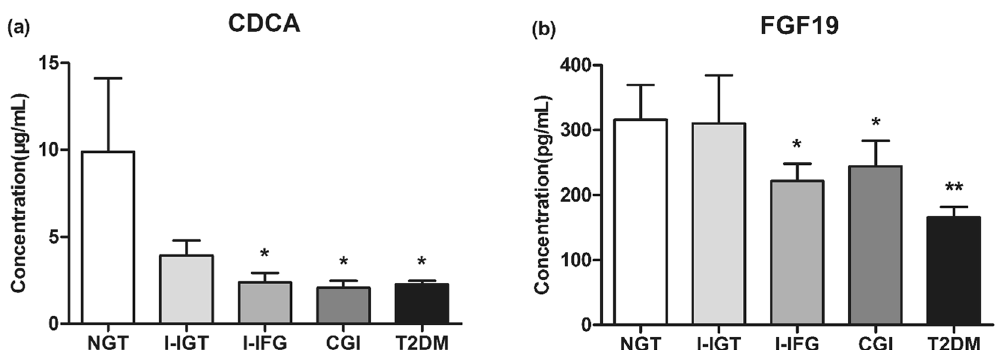
Figure 3. Fasting serum CDCA ( a ) and FGF19 ( b ) concentration in subjects with NGT (n = 10), I-IGT (n = 9), I-IFG (n = 10), CGI (n = 12) and T2DM (n = 24). * P < 0.05, vs. NGT; ** P < 0.01, vs.